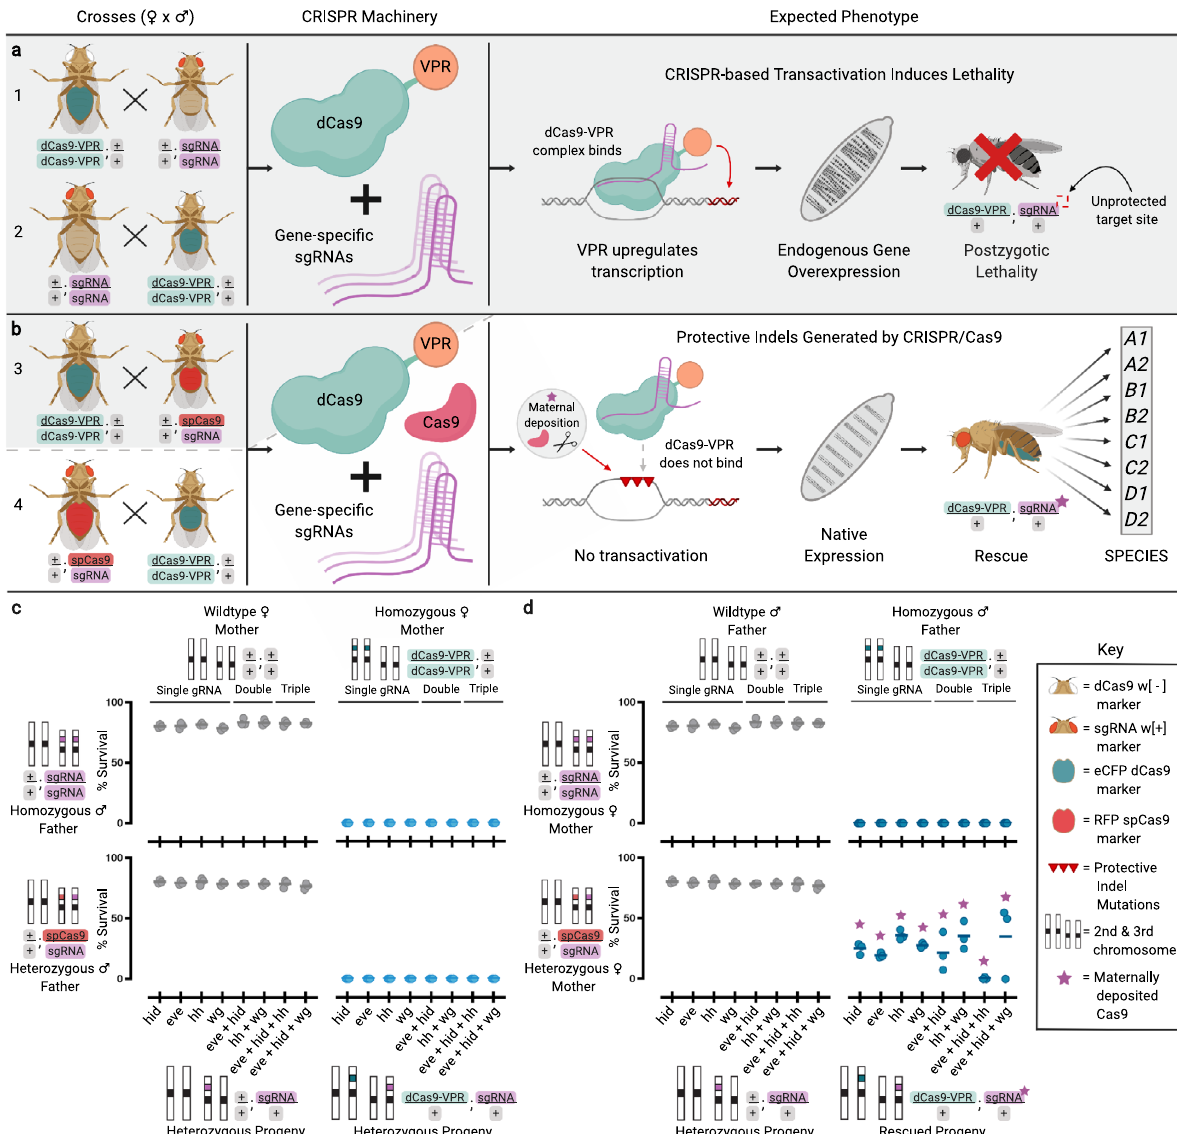
Fig. 1 Development of synthetic reproductive barriers. a Homozygous dCas9-VPR fl ies were crossed bidirectionally to homozygous sgRNA fl ies. Shaded gray background indicates expected lethal crosses. b Homozygous dCas9-VPR individuals were crossed bidirectionally to heterozygous spCas9/sgRNA individuals. Surviving individuals were repeatedly inbred to generate SPECIES. c , d Plots depicting % progeny survival from the crosses depicted in A and B. N = 3 biologically independent replicates for each gRNA combination (eight total combinations). Middle lines indicate mean. Gray dots indicate homozygous sgRNA and heterozygous spCas9/sgRNA fl ies crossed to wildtype fl ies. Light and dark blue dots indicate homozygous sgRNA and heterozygous spCas9/sgRNA fl ies crossed to homozygous dCas9-VPR mothers and fathers, respectively. Purple stars indicate the presence of maternally deposited Cas9. Source data are provided as a Source Data fi